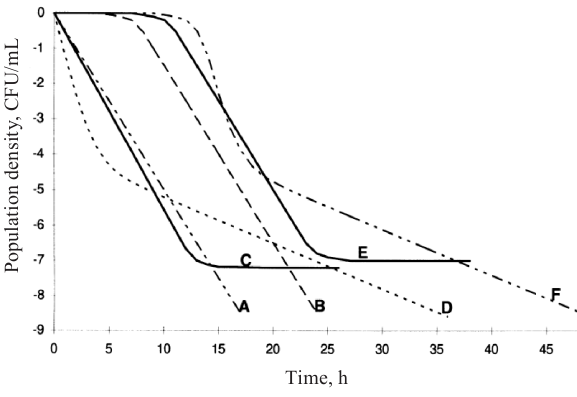
Figure 1 Dynamics of microbial death according to [15]. (A) linear kinetics; (B) linear kinetics with a lag phase; (C) and (D) nonlinear kinetics with ‘tails’; (E) and (F) sigmoidal